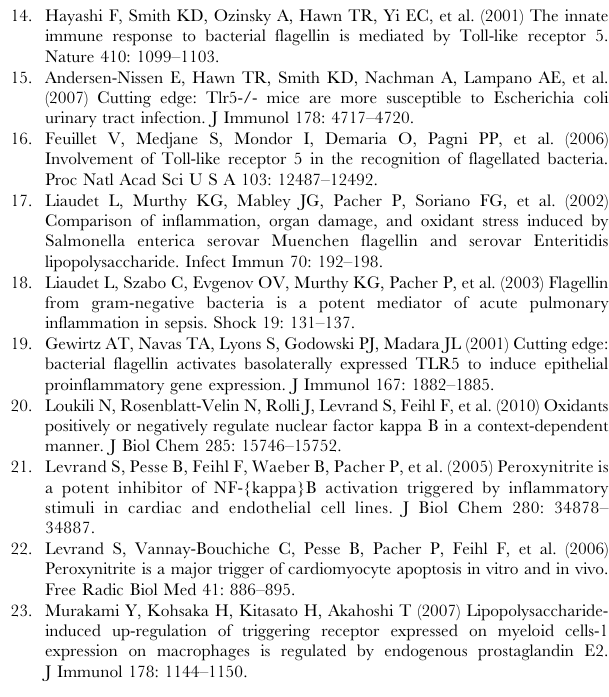
Figure 9. Flagellin transiently impairs cardiac function in anesthetized mice. A–B, Flagellin (1 m g) induced cardiac dilation at 4 and 24 h, but not 48 h, as shown by increased end-systolic and end-diastolic LV volumes. C–D, Flagellin significantly reduced LV maximal systolic pressure at 4 h and tended to increase LV end-diastolic pressure at 4 and 24 h. E–F, Flagellin did not induce changes of stroke volume, but significantly reduced LV ejection fraction at 4 and 24 h, but not 48 h. G–H, The slope of the ESPVR (Ees), as well as maximal elastance (Emax), were significantly reduced by flagellin, at 4 and 24 h, but not 48 h. I, Representative examples of end-systolic PV relationships (ESPVR) in control (C) and flagellin-treated mice at 4, 24 and 48 h. RVU: Relative Volume Units. * p , 0.05 versus control C (ANOVA followed by Dunnett test; n=5–7